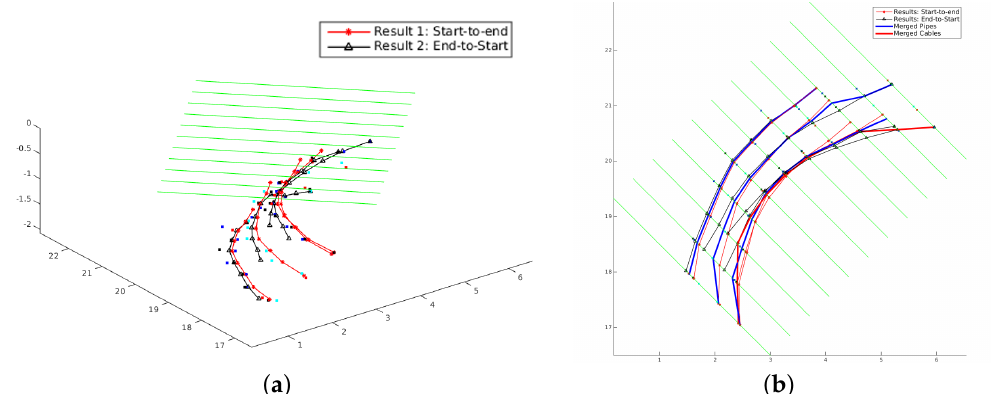
Figure 7. The results of the Marching-Cross-Section (MCS) algorithm by merging the corresponding results along two different marching directions. ( a ) 3D view of detected utility segments along two different marching directions; ( b ) 2D view of detected utility segments along two different marching directions and the final result after merging them together. After merging the results from two directions, the percentage of correctly detected utility segments increased from 84% and 87% to 95%. The missed 5% is due to no hypothesized detections generated in the corresponding area by any